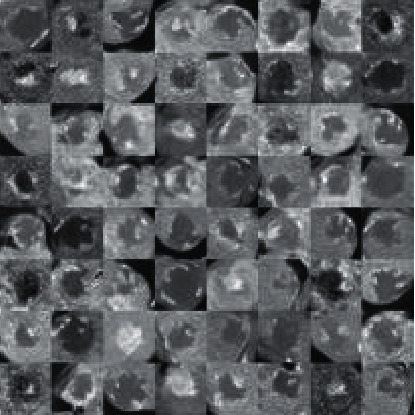
Image of hemangioma generated by CGAN [56].